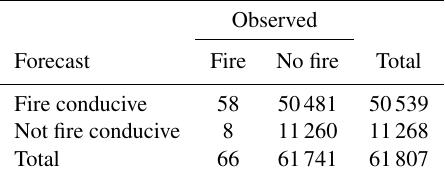
Table 2. Contingency table for the midnight 12h NWP-derived Fire Weather Index (FWI) component forecast for 2 May 2011, classi- fied using the Met Office Fire Severity Index (MOFSI) described in Kitchen et al. (2006) and Met Office (2005). Each 2km × 2km grid cell within Great Britain is represented as a unit value and assigned to one element of the 4 × 4 matrix below, based upon whether a fire is burning in that particular grid cell and whether fire danger condi- tions are conducive to fire. For the purpose of this analysis, grid cells where the FWI value was categorised as “high”, “very high” or “ex- ceptional” were considered to be conducive to fire. Wildfire obser- vations are taken from the IRS database. Hit rate ( H ) = 0.71, false-